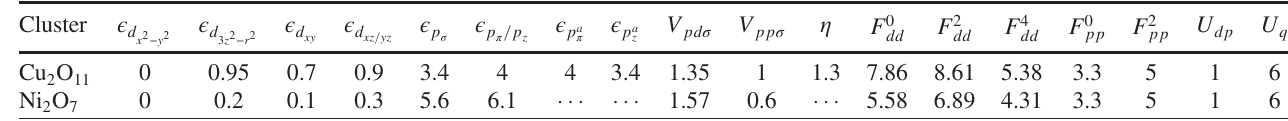
¼ Δ [65]. Note that V , V , V , and V are amplitudes of p σ pd σ pd π pp σ pp π ¼ − V ¼ − V ¼ ð V − V Þ = 2 = 2 and V = 4 . Correspondingly, t pd π pd σ pp π pp σ p σ p σ pp σ pp π